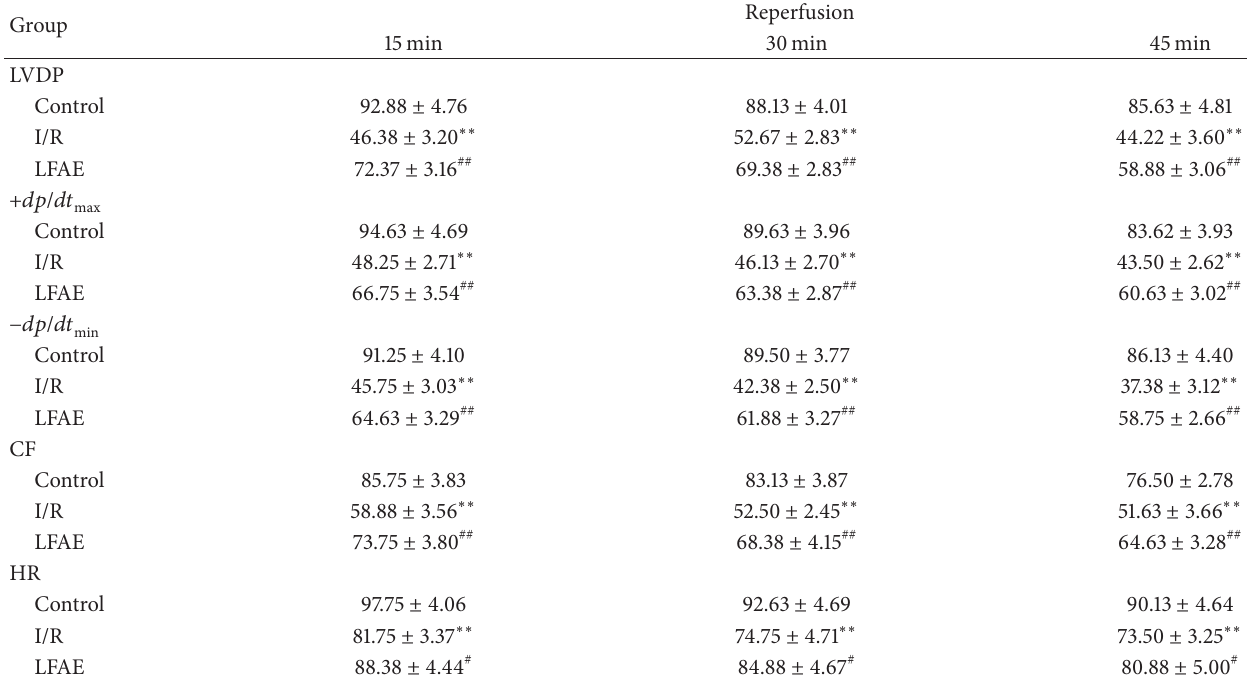
Table 3: Supplemental data for Figure